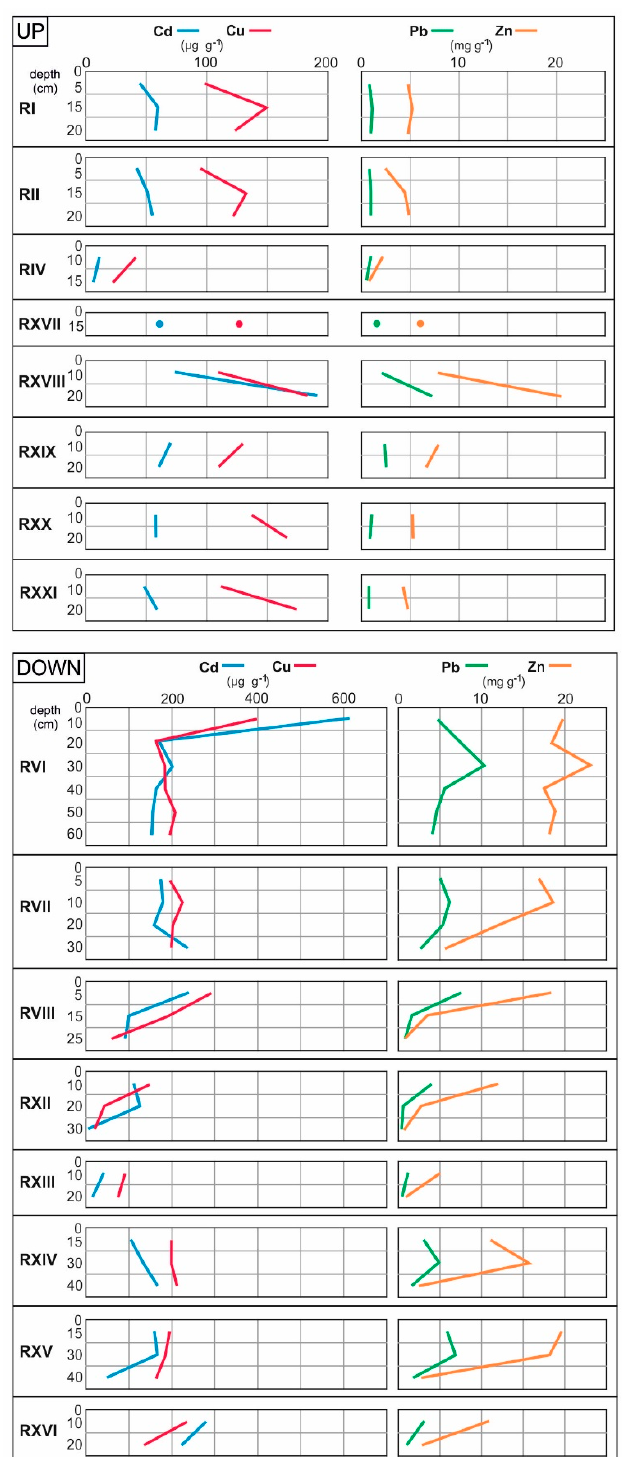
Figure 2. Heavy metal concentrations in the sediment cores in subsidence ponds (UP: Subsidence pond after the closure of the mine; cores: RI, RII, RIV, RXVII, RXVIII, RXIX, RXX, RXXI; DOWN: Subsidence ponds during peak exploitation; cores: RVI, RVII, RVIII, RXII, RXIII, RXIV, RXV, RXVI).